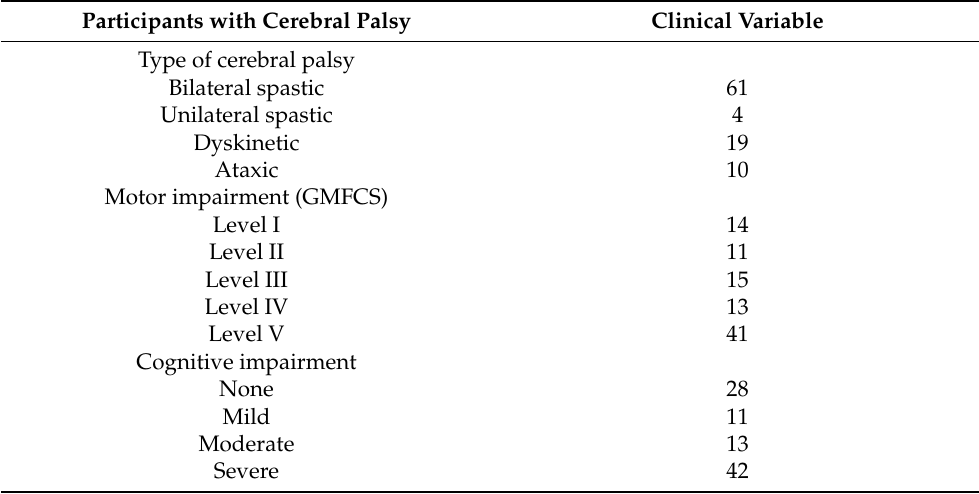
Table 1. Clinical characteristics of individuals with cerebral palsy. GMFCS = Gross motor function classification system; describes the gross motor function according to 5 levels: 1 = walks without limitations, 5 = transported in a manual